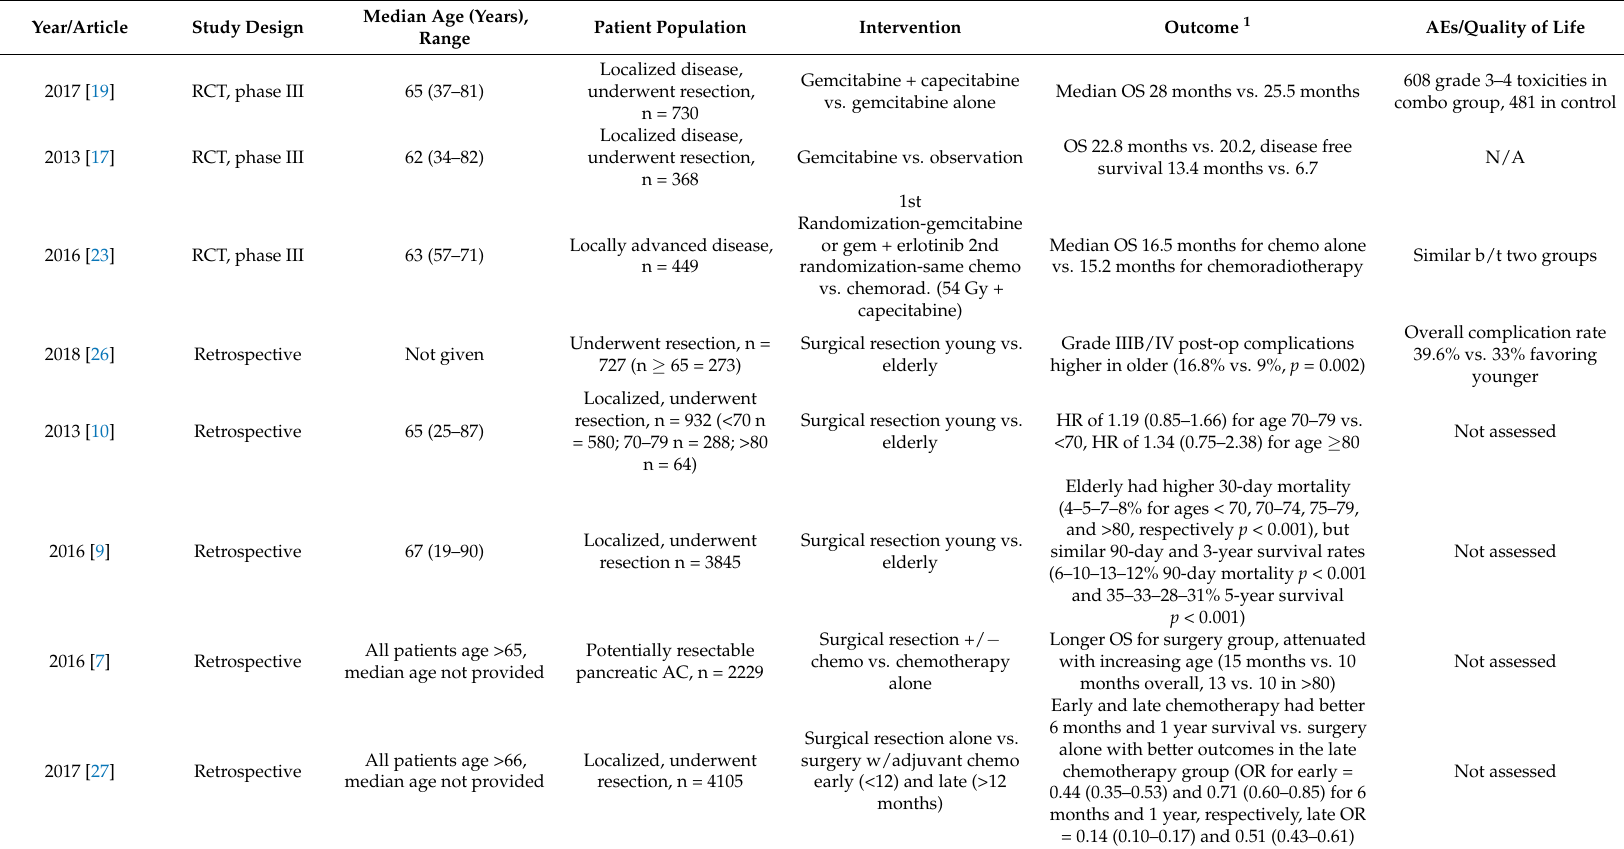
Table 1. Articles comparing different treatments for localized Pancreatic